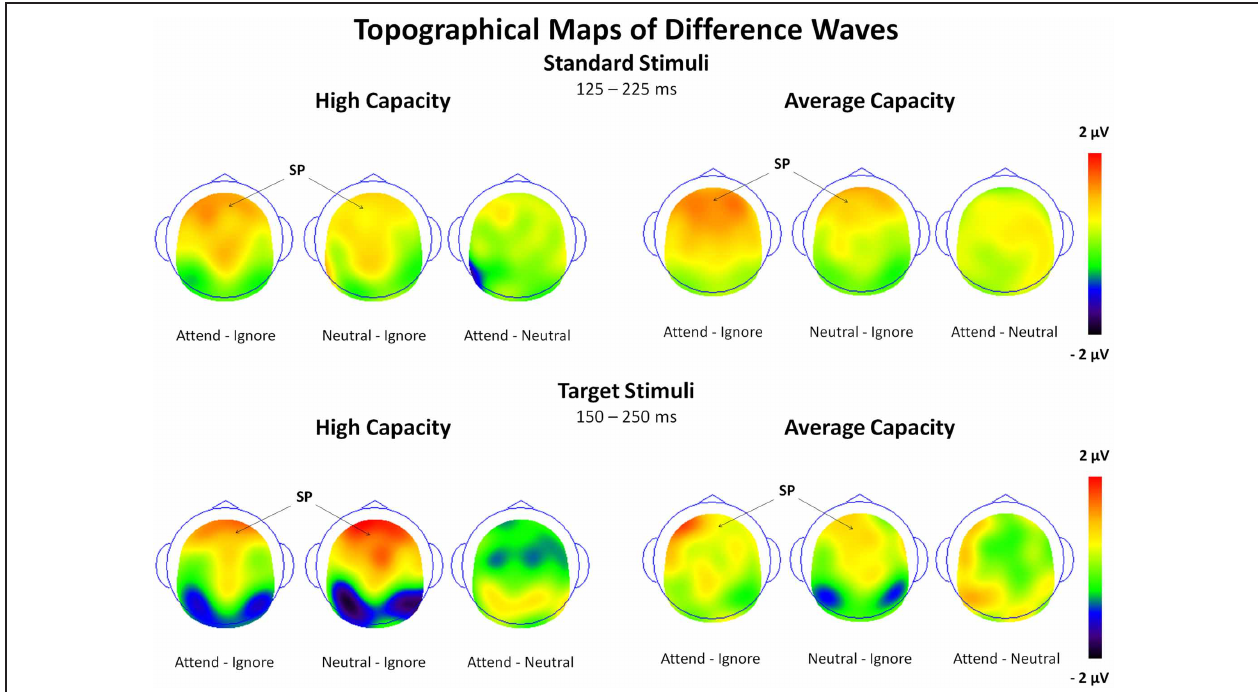
FIGURE 5 | Surface potential maps of difference waves under Attend—Ignore, Neutral—Ignore, and Attend—Neutral conditions for the SP interval for highcapacityandaveragecapacitysubjectsinresponsetostandardstimuliandtargetstimuli. Arrowsillustrate thepresence oftheSelection Positivity(SP).